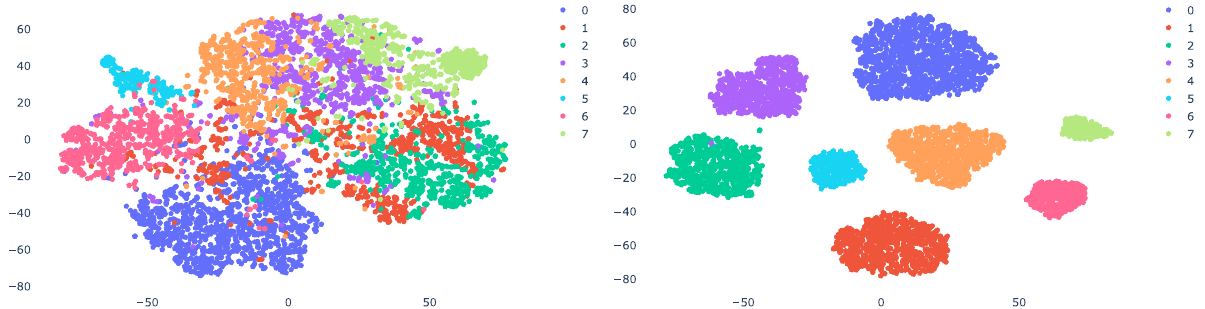
Figure 7. (Left) shows the t-sne visualization of the vector embedding obtained by a random walk for the simulated data. Right) shows the t-sne visualization of the vector embedding of the finWalk strategy. The images show that the finWalk strategy yields a better cluster